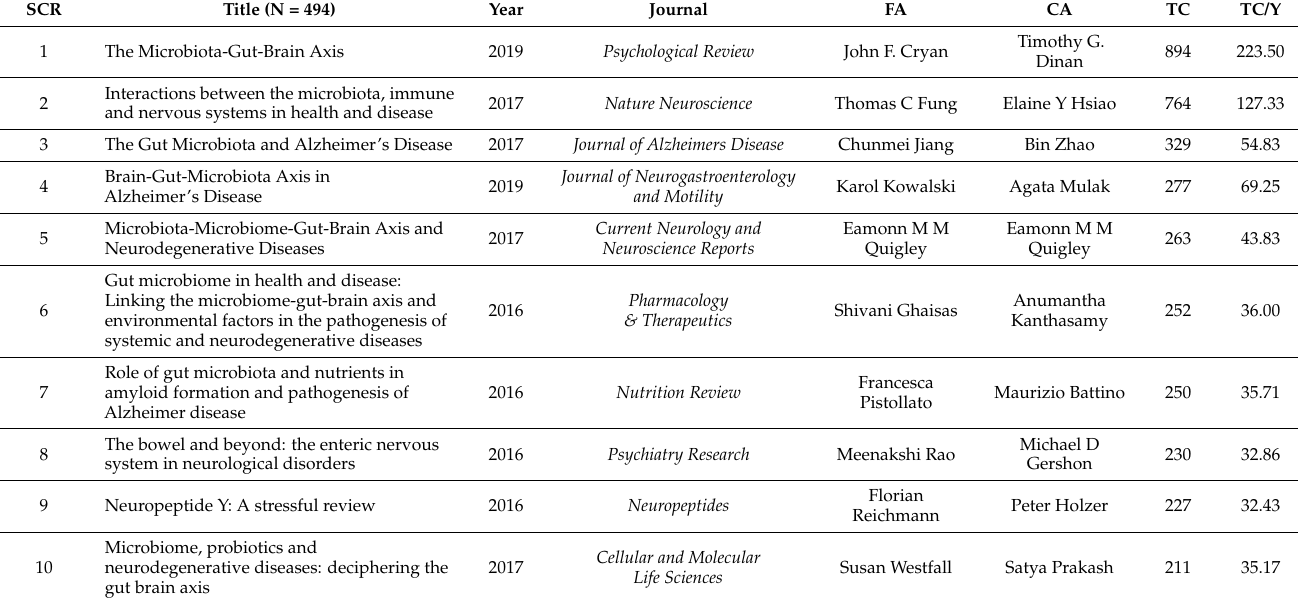
Table 1. Top 10 most cited articles on microbiome–gut–brain axis and dementia related research.